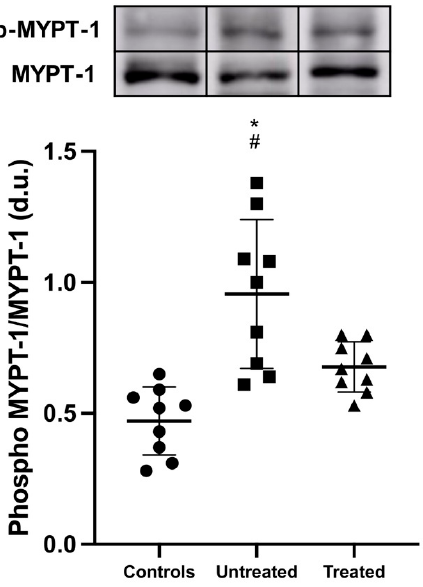
Figure 2. MYPT-1 phosphorylation state. A representative Western blot of protein lysates harvested from controls, untreated ADPKD patients and tolvaptan-treated ADPKD patients. Compared to controls, phospho-MYPT-1 was significantly increased in untreated ADPKD patients (*: p < 0.001) and in treated ADPKD patients (#: p = 0.013).